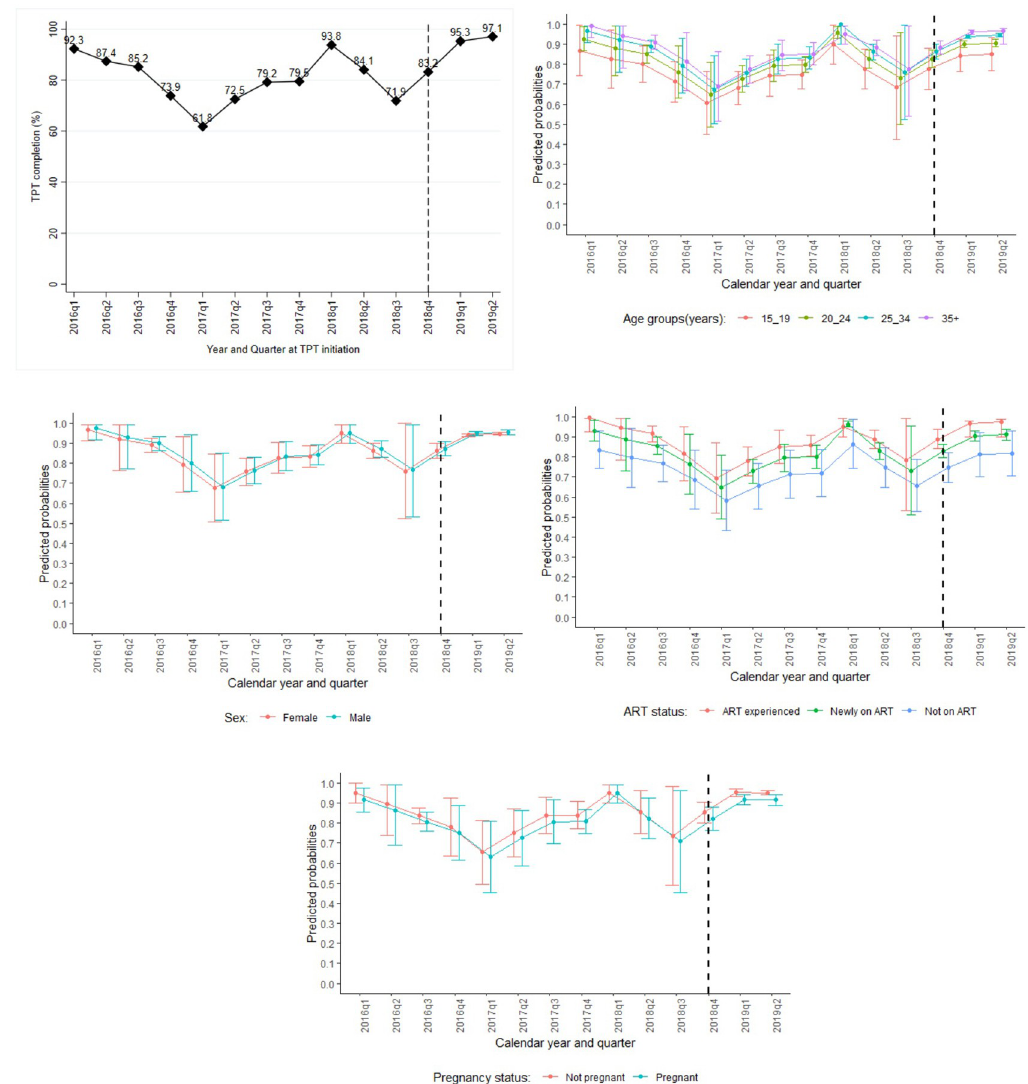
Fig 3. a: Trend of TPT completion by calendar years and quarters. q1, q2, q3, and q4 denote quarters 1,2,3, and 4 respectively. The vertical dotted line at 2018q4 marks a point from which the 100-day TPT accelerated intervention targeted to achieve 100% completion. Trend graph truncated at 2019q2, a point which PLHIV initiated on TPT during the period studied were expected to have completed their 6-months TPT dose. b: Trend of predicted probabilities of TPT completion by age groups. q1, q2, q3, and q4 denote quarters 1,2,3, and 4 respectively. The vertical dotted line at 2018q4 marks a point from which the 100-day TPT accelerated intervention targeted to achieve 100% completion. Trend graph truncated at 2019q2, a point which PLHIV initiated on TPT during the period studied were expected to have completed their 6-months TPT dose. c: Trend predicted probabilities of TPT uptake by sex. q1, q2, q3, and q4 denote quarters 1,2,3, and 4 respectively. The vertical dotted line at 2018q4 marks a point from which the 100-day TPT accelerated intervention targeted to achieve 100% completion. Trend graph truncated at 2019q2, a point which PLHIV initiated on TPT during the period studied were expected to have completed their 6-months TPT dose. d: Trend of TPT completion by ART status. q1, q2, q3, and q4 denote quarters 1,2,3, and 4 respectively. The vertical dotted line at 2018q4 marks a point from which the 100-day TPT accelerated intervention targeted to achieve 100% completion. Trend graph truncated at 2019q2, a point which PLHIV initiated on TPT during the period studied were expected to have completed their 6-months TPT dose. e: Trend predicted probabilities of TPT completion by pregnancy status. q1, q2, q3, and q4 denote quarters 1,2,3, and 4 respectively. The vertical dotted line at 2018q4 marks a point from which the 100-day TPT accelerated intervention targeted to achieve 100% completion. Trend graph truncated at 2019q2, a point which PLHIV initiated on TPT during the period studied were expected to have completed their 6-months TPT